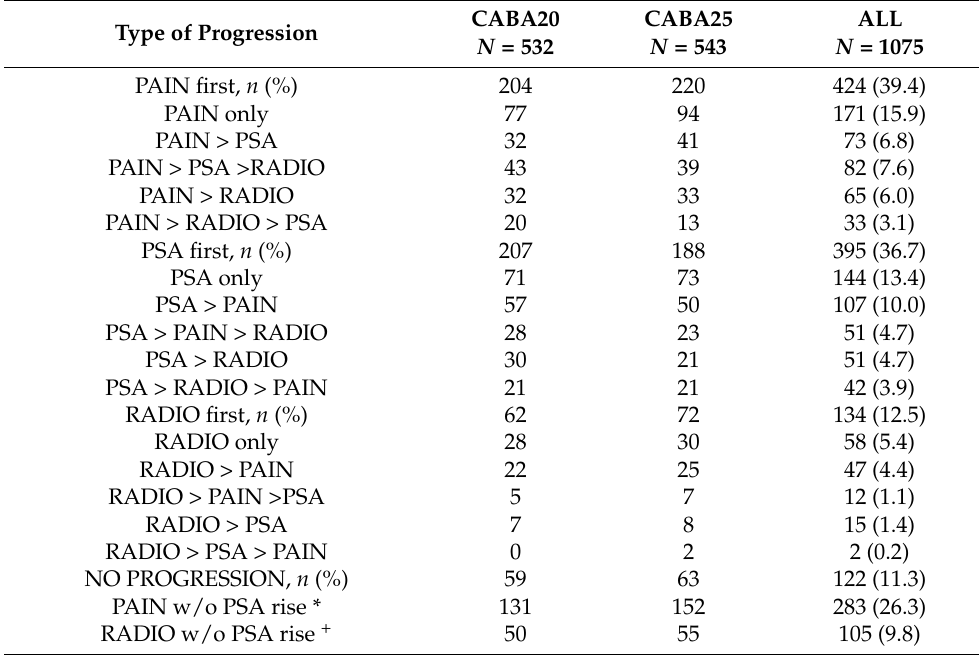
Table 4. Patterns of progression by treatment arm and overall